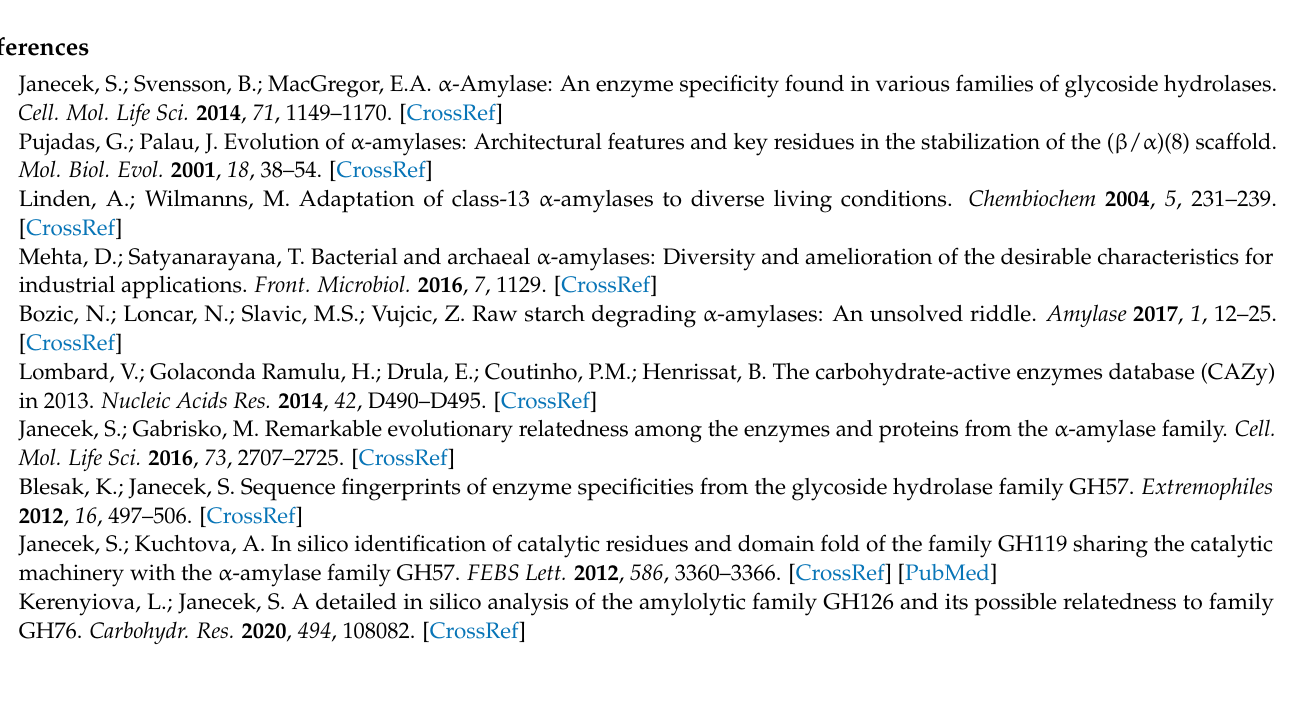
Supplementary Materials: Figure S1: Sequence alignment of all 268 collected sequences represent- Figure S2: Evolutionary trees of studied α -amylases based on the alignment of (a) sequences span- ning the segment between the strands β 1 and β 8 of catalytic TIM-barrel; and (b) extracted eight conserved sequence regions. Table S1: List of 268 sequences from GH13 subfamilies containing fungal and chloride-dependent α